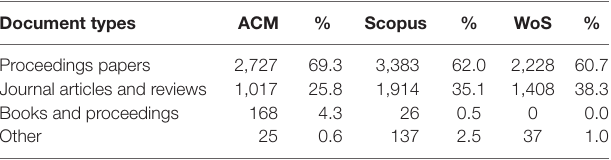
taBlE 2 | Document types per databases, in absolute numbers and percentages.